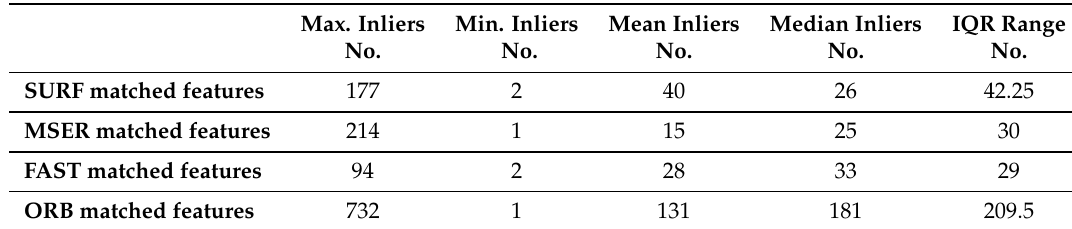
Table 2. Maximum (Max.), Minimum (Min.), Mean, Median, and Interquartile Range (IQR) of matched features on all patients after outlier removal per unit of time (pair of